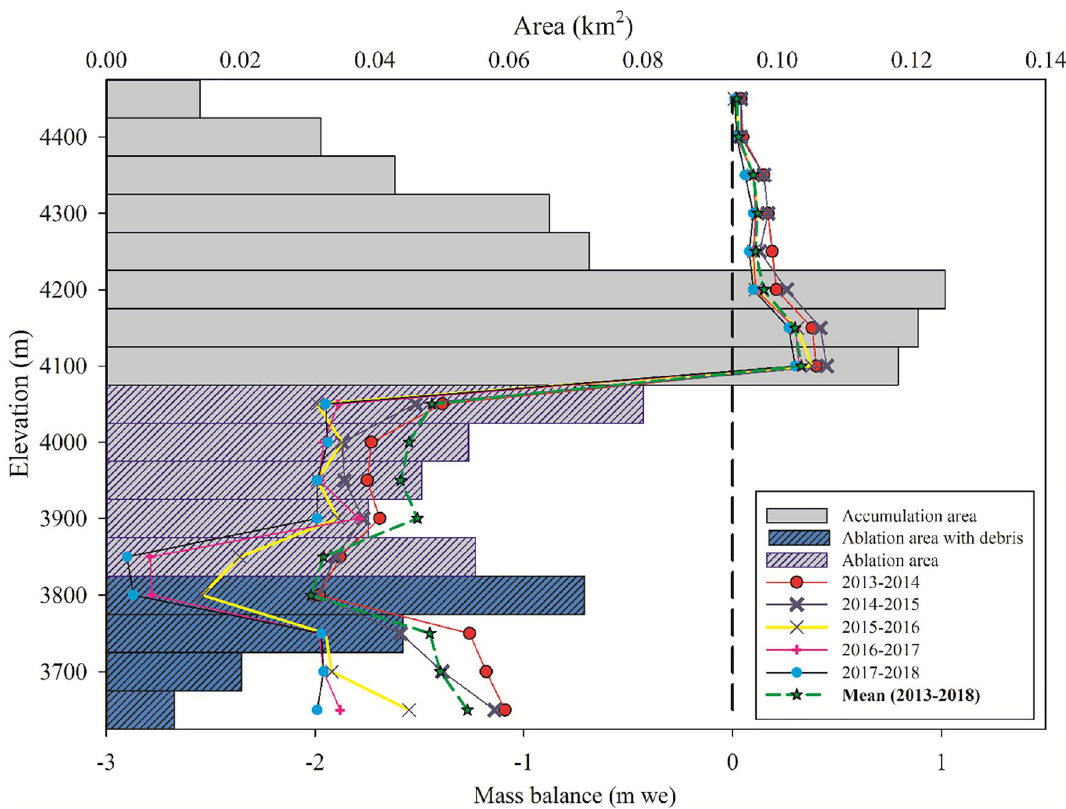
Figure 2. Specific mass balance of the Hoksar Glacier w.r.t. elevation during 2013–2018 derived from the spatially averaged measurements over the given altitudinal band.